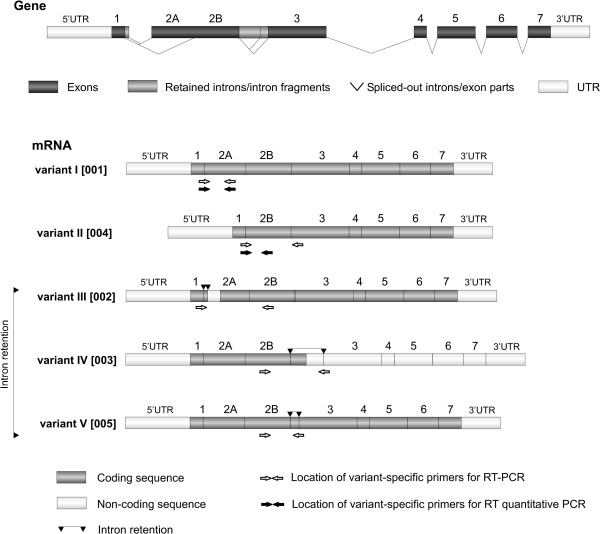
Alternative splicing of the human HAX1. Only five splice variants, generating putative protein product maintained in the same reading frame are depicted. Variants are named as in Carlsson et al., 2008 [25], nomenclature from Lees et al., 2008 [26] in brackets. The location of the variant-specific primers is depicted by arrows.